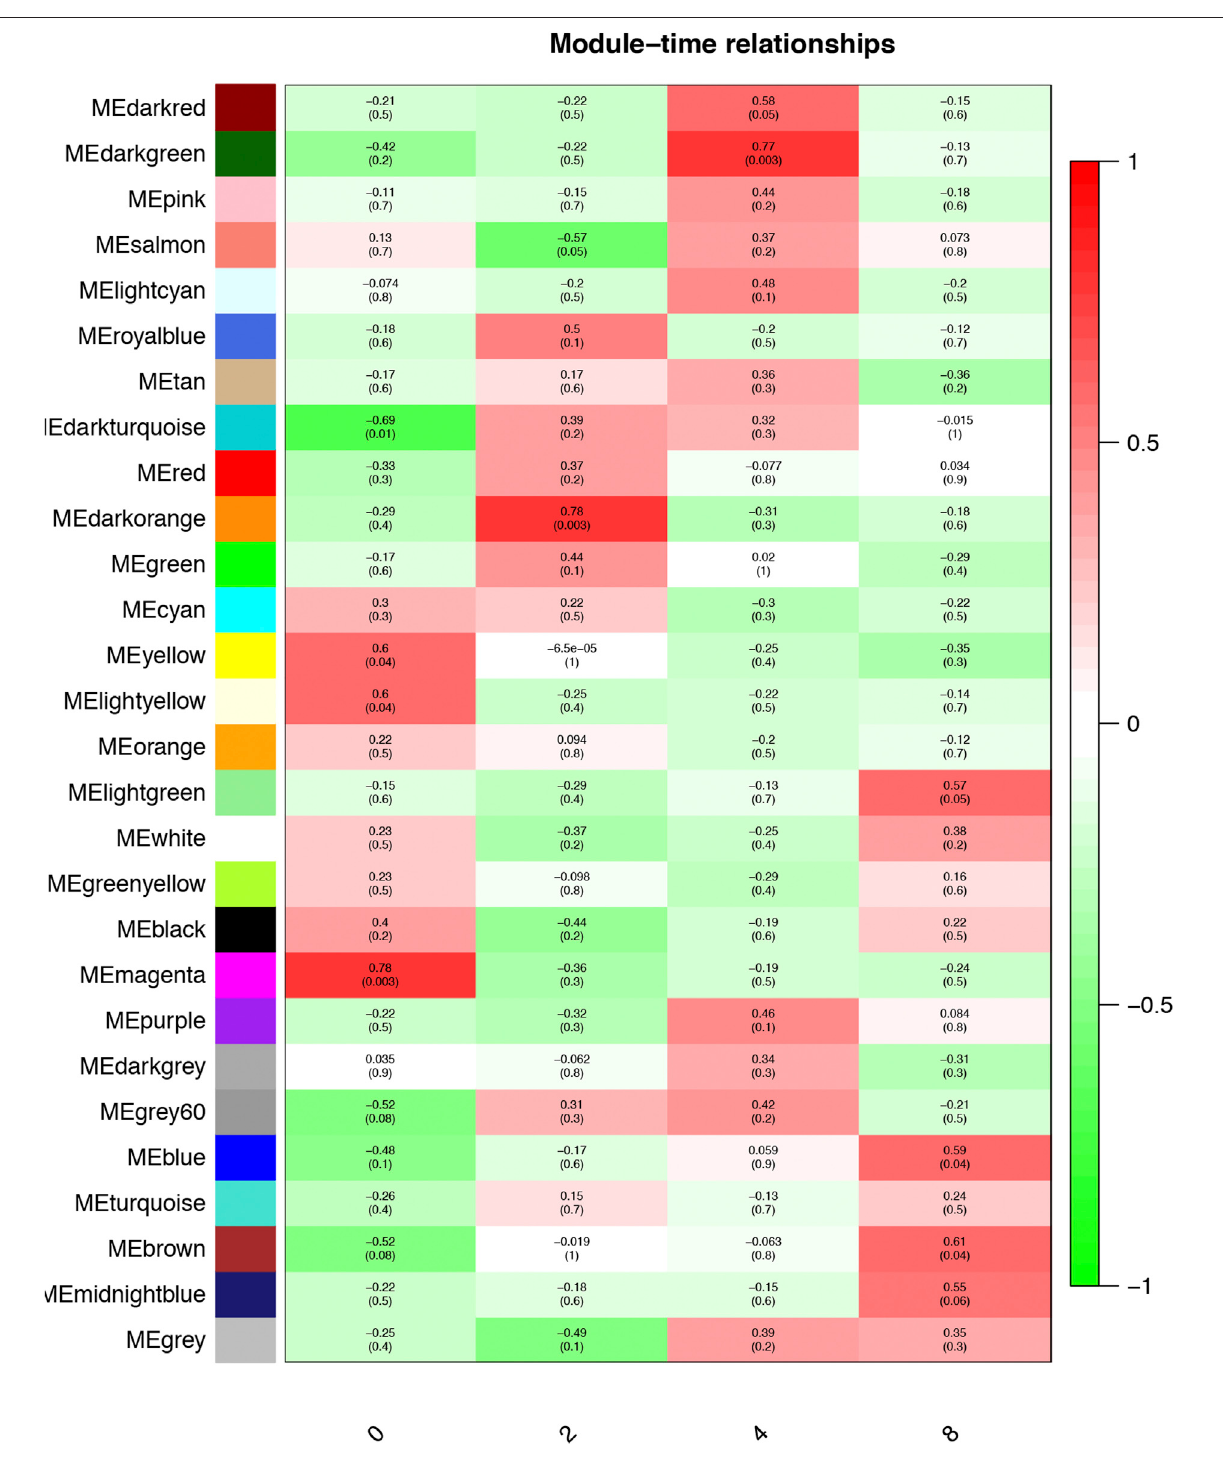
FIGURE 3 | Module – time correlation. Correlation between gene modules and sample information, with the x- and y-axes representing preadipocyte differentiation time points and gene modules, respectively. The darker the color, the higher the correlation, with red and green representing positive and negative correlation, respectively. The p -value is enclosed in